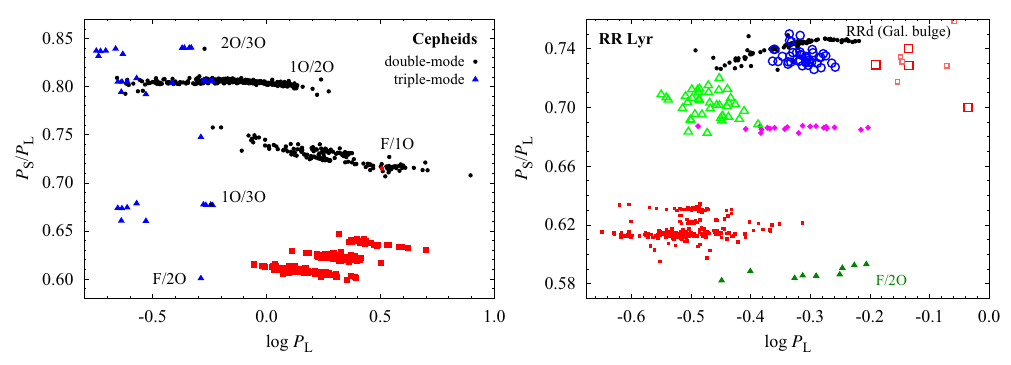
Figure 1. Petersen diagram (shorter-to-longer period ratio vs. log of longer period) for classical Cepheids (left panel) and RR Lyr stars (right panel) with various classes of multi-mode pulsators plotted with di ff erent